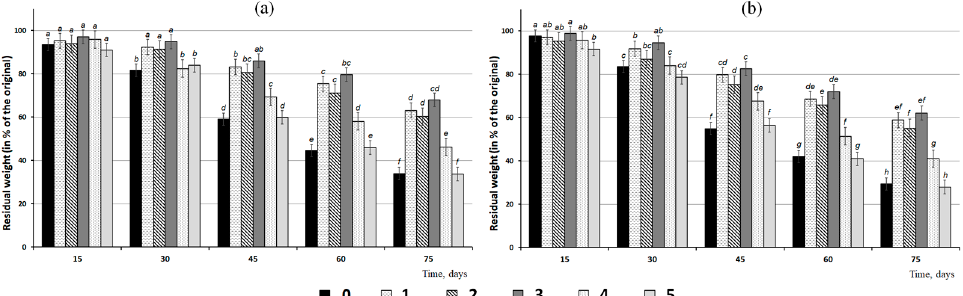
Figure 8. The weight loss of fungicide-loaded granules of two sizes (( a )—3.0; ( b )—1.5 mm) incu- bated in soil: 0—unloaded formulation; 1—P(3HB)/wood flour/difenoconazole; 2—P(3HB)/wood flour/azoxystrobin; 3—P(3HB)/wood flour/prothioconazole; 4—P(3HB)/wood flour/azoxystrobin + mefenoxam; 5—P(3HB)/wood flour/mefenoxam. The letters indicate the significance of differences when comparing groups according to the Mann-Whitney test at the level of p < 0.05; identical letters indicate no significant differences.